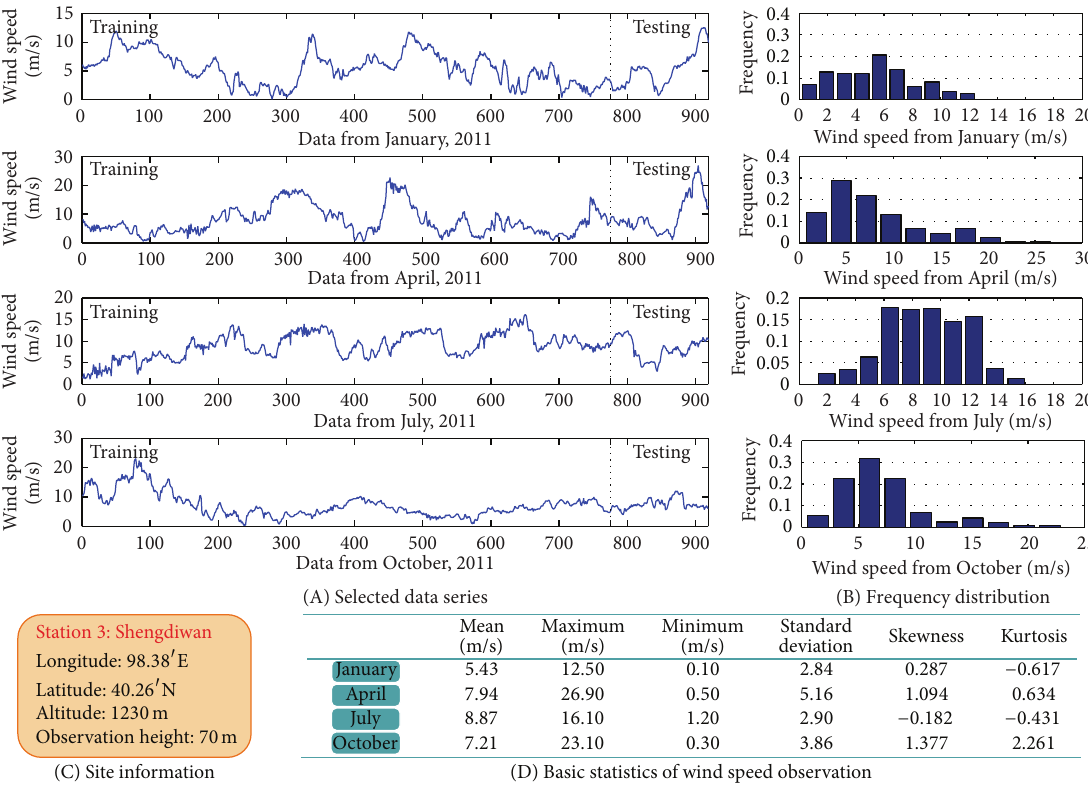
Kurtosis Station 3 : Shengdiwan